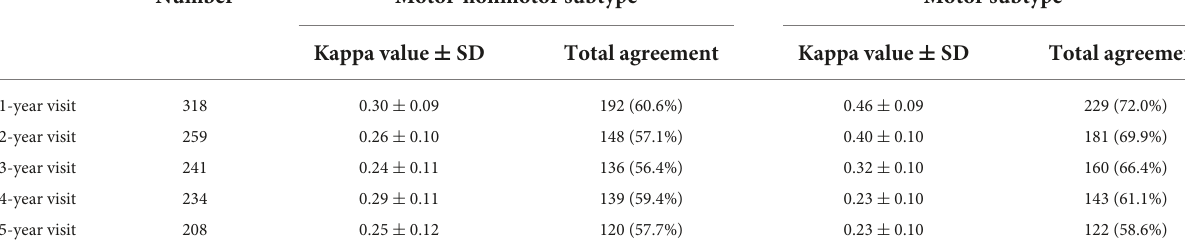
TABLE 2 Consistency of subtypes during follow-up compared to